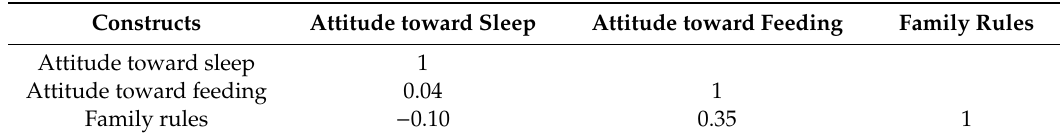
Table 3. Correlation matrix of multi-item